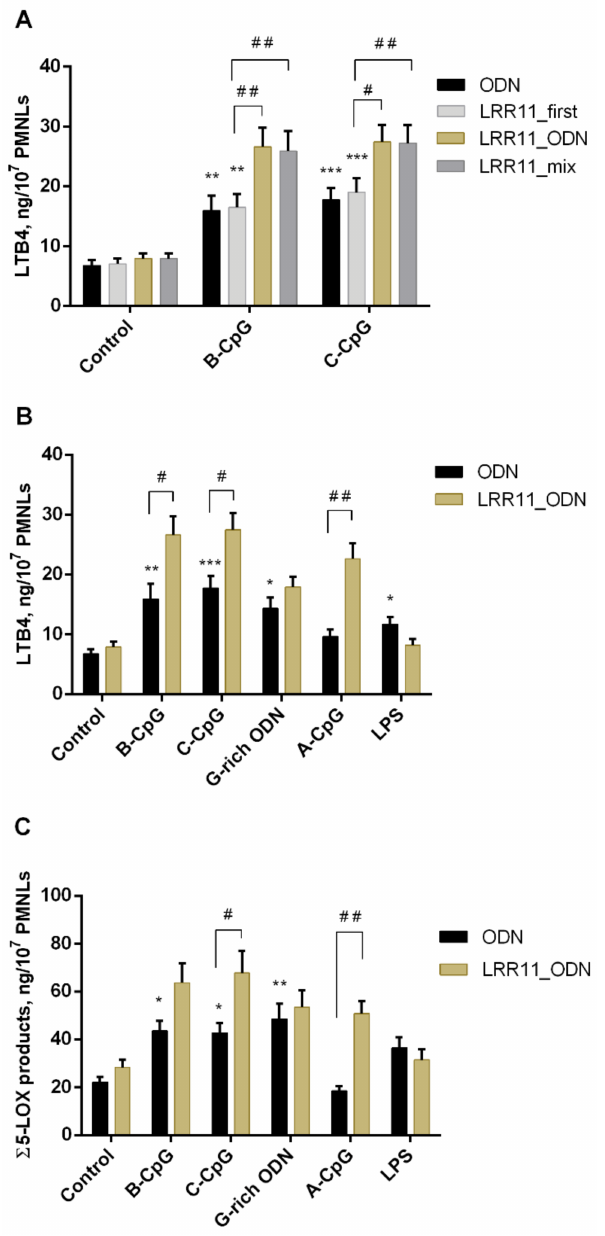
Figure 1. Effects of LRR11 and ODNs on the formation of LTB4 ( A , B ) and the sum of 5-LOX metabolites ( ω -OH-LTB4, LTB4 and its isomers, and 5-HETE) ( C ) in human PMNLs. PMNLs (2 × 10 7 ) were incubated for 15 min at 37 ◦ C without (black bars) or with 1 µ M LRR11 (A, LRR11_first); then ODNs and LRR11 or LPS were added; various ways of adding ODN and LRR11 peptide are indicated. In control samples, Hanks’ solution was added instead of ODNs. After 20 min, 0.5 × 10 9 S. typhimurium bacterial cells were added for a further 15 min. The 5-LOX products were determined using HPLC. Values indicate mean ± SEM of five independent experiments performed in duplicate. * p < 0.05, ** p < 0.01, *** p < 0.005, compared with the control. # p < 0.05, ## p < 0.01 for pairs of data compared as indicated by two-way ANOVA followed by Tukey’s multiple comparison